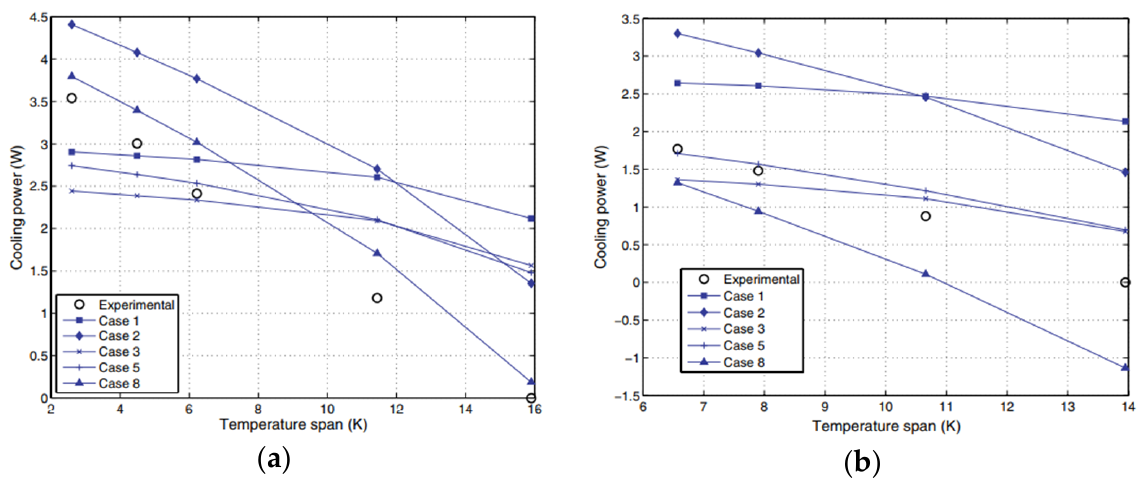
Figure 16. Cooling powers evolution versus the temperature range for several cases with a: ( a ) narrow regenerator; ( b ) wide regenerator [97].